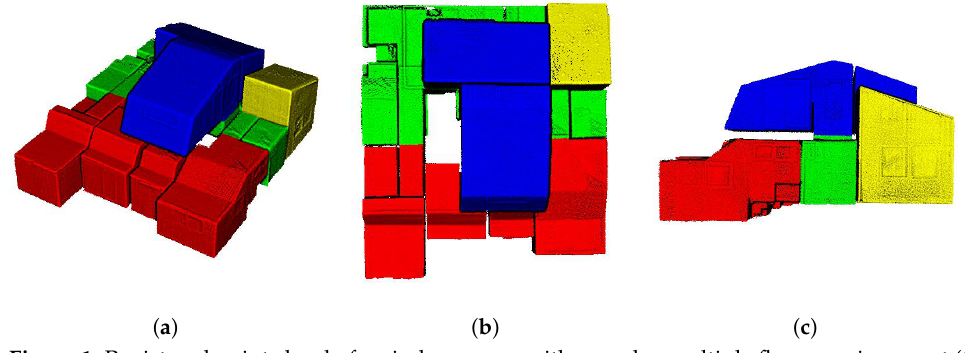
Figure 1. Registered point cloud of an indoor space with complex multiple floors environment (C2 in our dataset). ( a ) The bird’s-eye view, ( b ) top view, and ( c ) side view of the indoor space. The combination of first and 0.5 floors is denoted by red, first floor is denoted by green, second floor is denoted by blue, and a combination of first and second floors is denoted by yellow. The conventional horizontal slicing approach is not suitable for complex multi-level building environments.